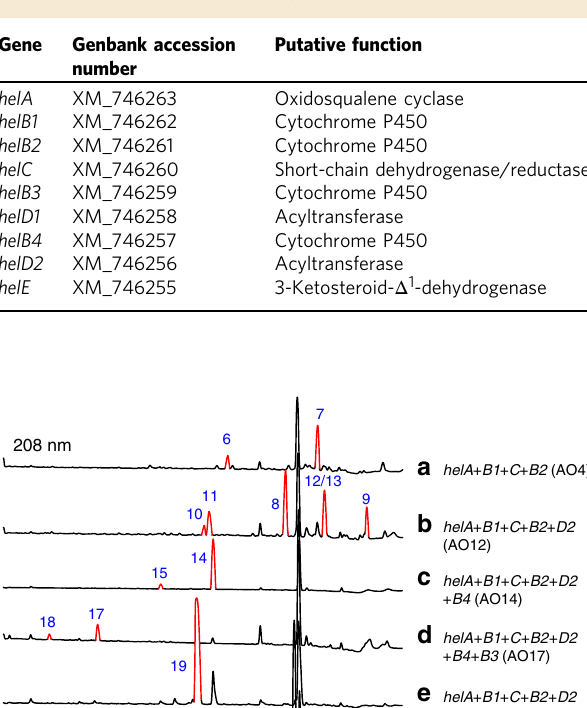
Table 1 Putative functions of genes in the hel